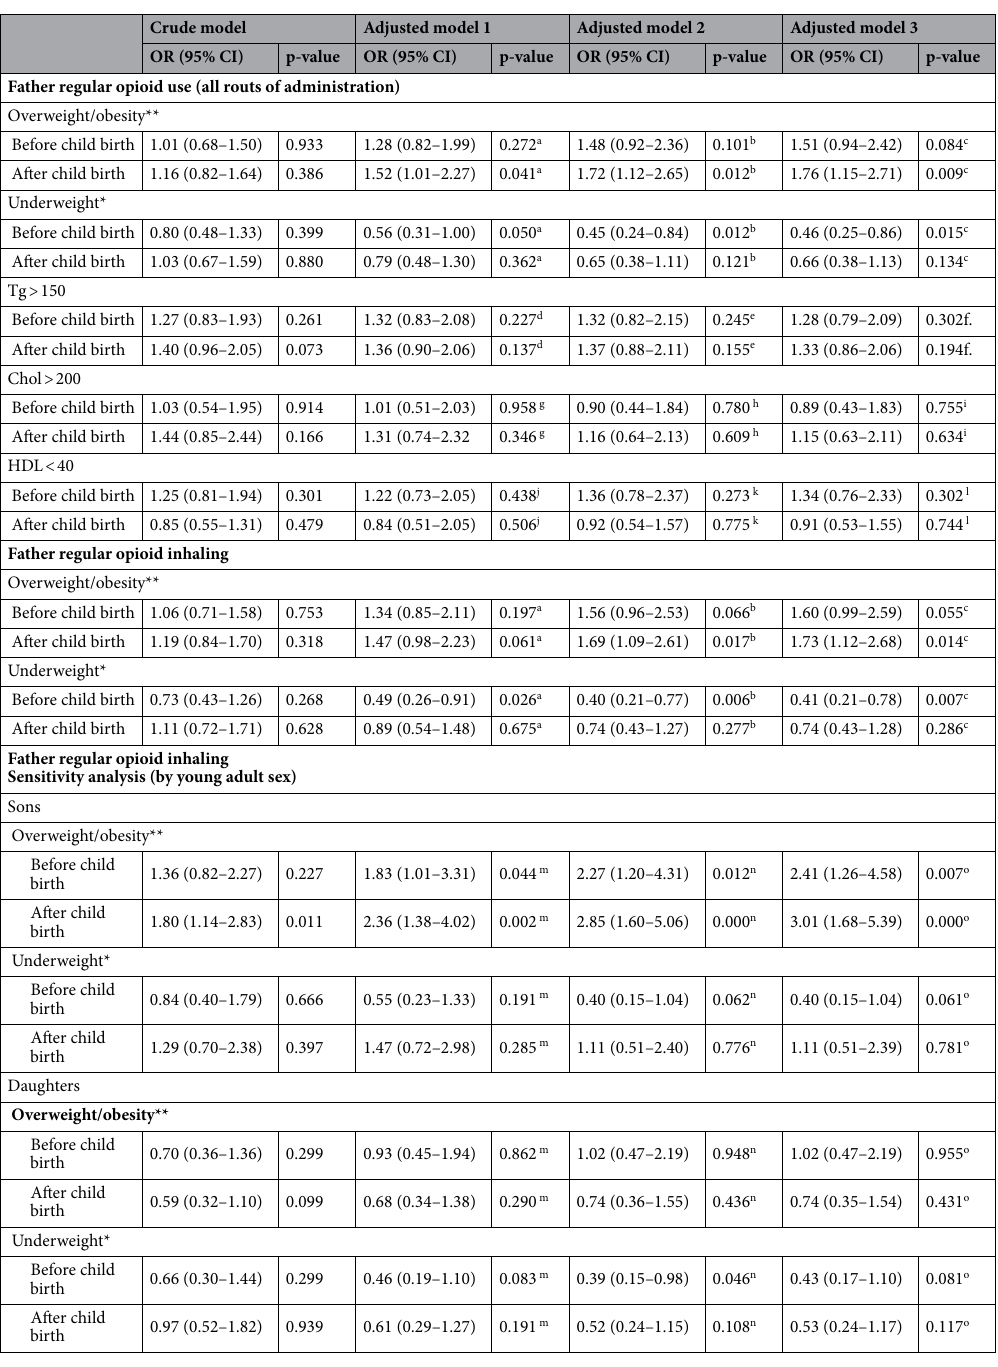
Table 3. Estimated crude and adjusted odds ratios for the overweight/obesity, underweight, high Tg, high Chol. and low HDL in Offspring, as predicted by paternal exposure to opioid. OR odds ratio, CI confidence interval, BMI: body mass index, HDL: high density lipoprotein, Chol: cholesterol. Serum HDL-Chol, WSI: socioeconomic index. a Adjusted for age, sex, father and mother BMI. b Adjusted for age, sex, father and mother BMI, father smoking. c Adjusted for age, sex, father and mother BMI, father smoking, father WSI. d Adjusted for age, sex, father and mother Tg. e Adjusted for age, sex, father and mother Tg, father smoking. f Adjusted